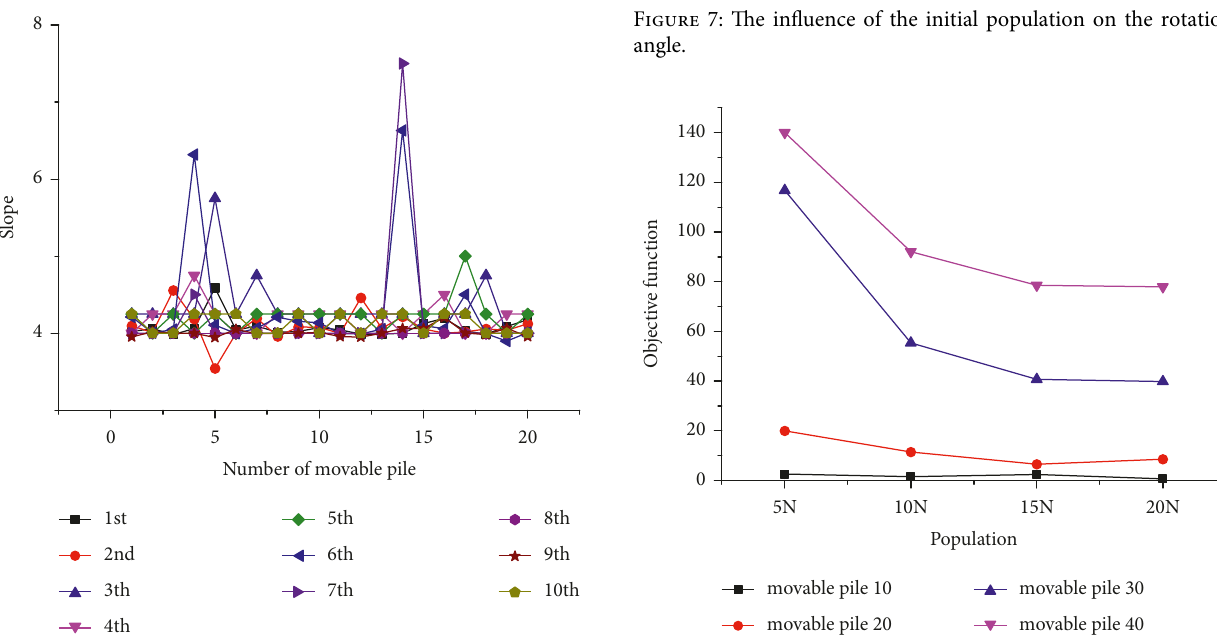
Figure 6: The influence of the initial population on the pile slope.